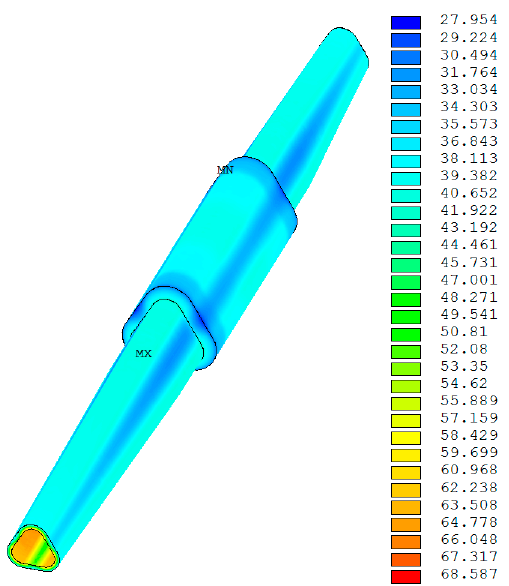
Figure 15. The temperature profile of armor wrap using finite element method (FEM) thermal analysis.